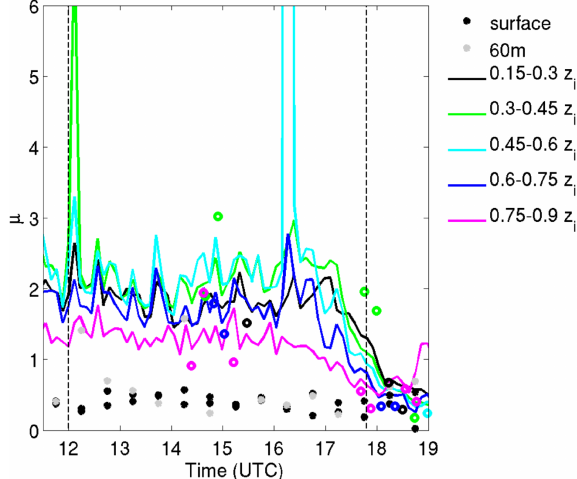
Figure 12. Temporal evolution of the parameter µ , obtained from the KL89 analytical model, by using LES (continuous lines), air- craft (open circles) and surface (closed circles) data. The vertical dashed lines stand for the times of maximum surface buoyancy flux (at 12:00UTC) and its zero value (at